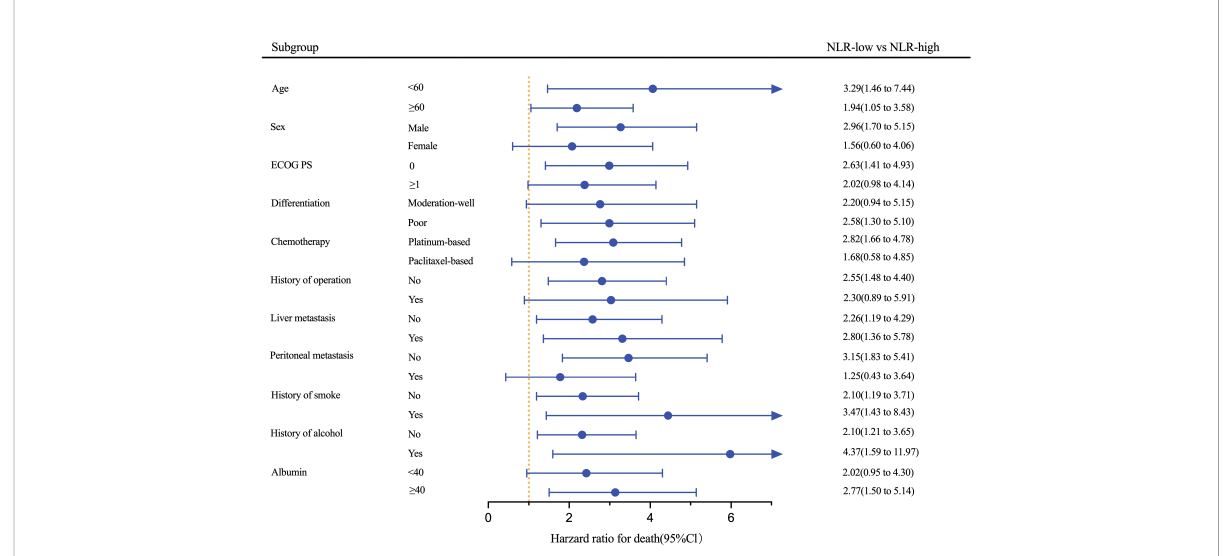
FIGURE 4 Forest plot of HRs for PFS based on the pooled cohort strati fi ed by NLR cut-off. ECOG PS , Eastern Cooperative Oncology Group Performance Status ; NLR , neutrophil-to-lymphocyte